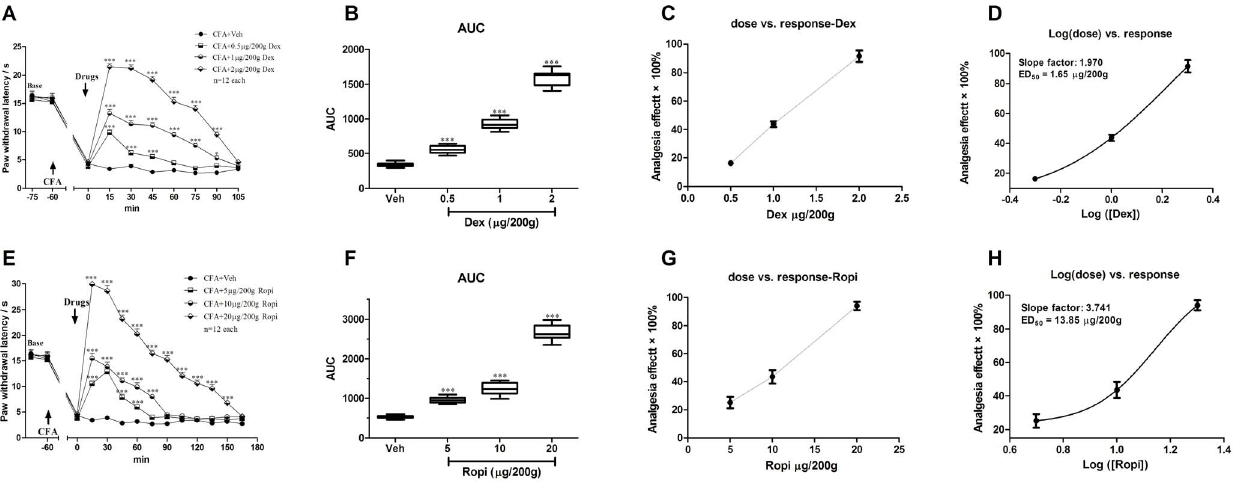
Figure 2. i.t. Dex or Ropi dose-dependently inhibited CFA-induced thermal hyperalgesia of the injected hind paw. Analgesia duration of different doses of i.t. Dex or Ropi was shown in A and E . The AUCs for different groups were calculated to perform statistical analysis ( B ) and ( F ). The dose-effect or log (dose)-effect curves for the analgesic effects in attenuating CFA-induced thermal hyperalgesia after i.t. vehicle and Dex or Ropi were shown in C or G and D or H , respectively.* p , 0.05; *** p , 0.001, compared with CFA-Veh group; arrows indicated s.c. CFA injection and i.t. intervention time point, respectively. ( Figure 5F ; one-way ANOVA, P , 0.001). Bonferroni’s post hoc test also revealed a significant group difference between CFA-Dex, CFA-Ropi, or CFA-Dex&Ropi and Saline-Veh or CFA-Veh group ( P , 0.001), respectively, at 2 h. The number of Fos-ir neurons reduced to the equal with Saline-Veh group at day 3 ( P . 0.05). However, no significant difference was observed among CFA-Dex, CFA-Ropi, and CFA-Dex&Ropi ( P . 0.05). These results suggested that a synergistic effect might exist because although the dose of ED 50comb Dex&Ropi was lower than individural ED 50 , equal inhibition on the neuronal activation in the initiation phase was achieved.